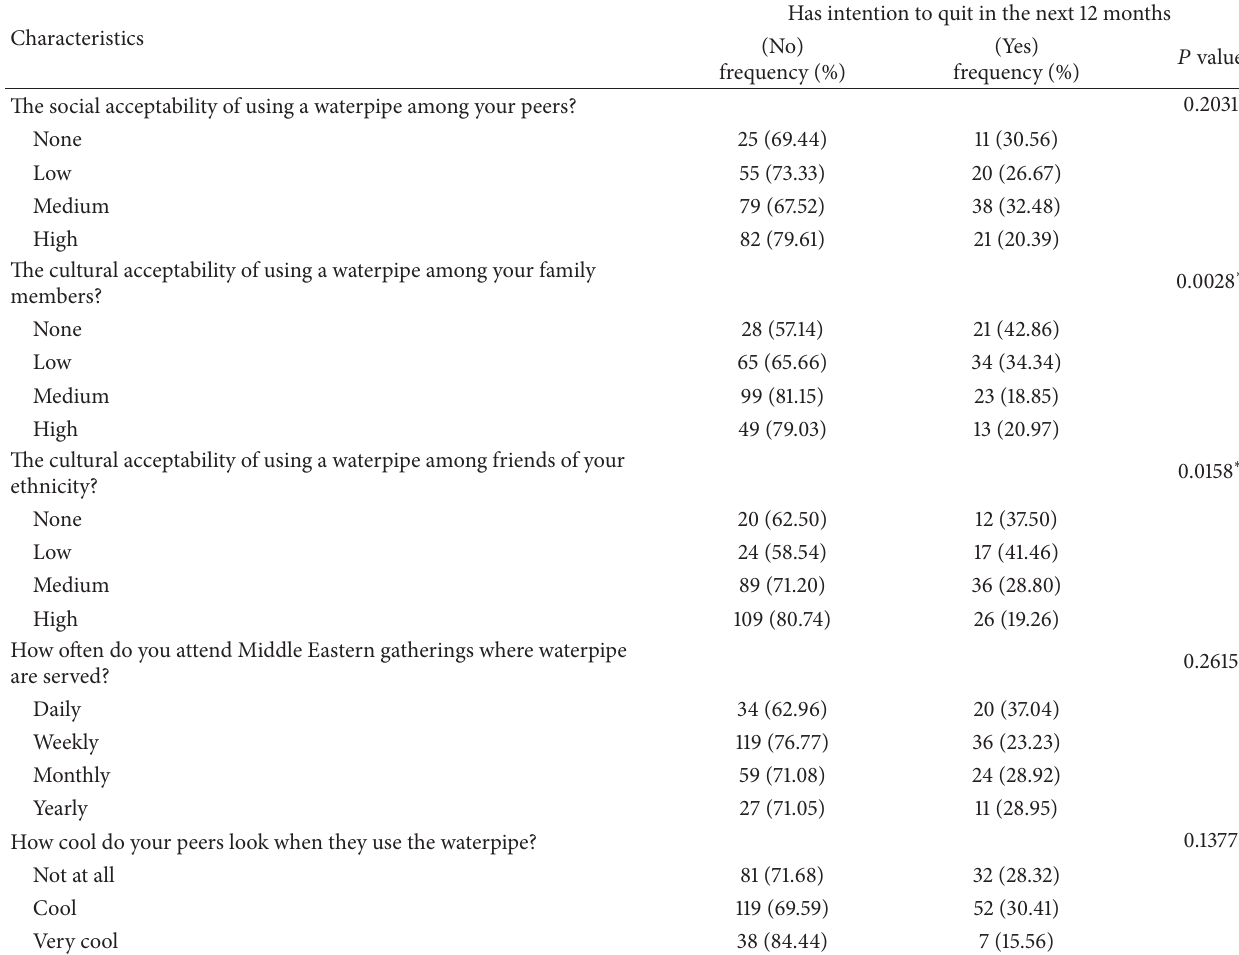
Table 3: Frequency of intention to quit waterpipe smoking with perceived social